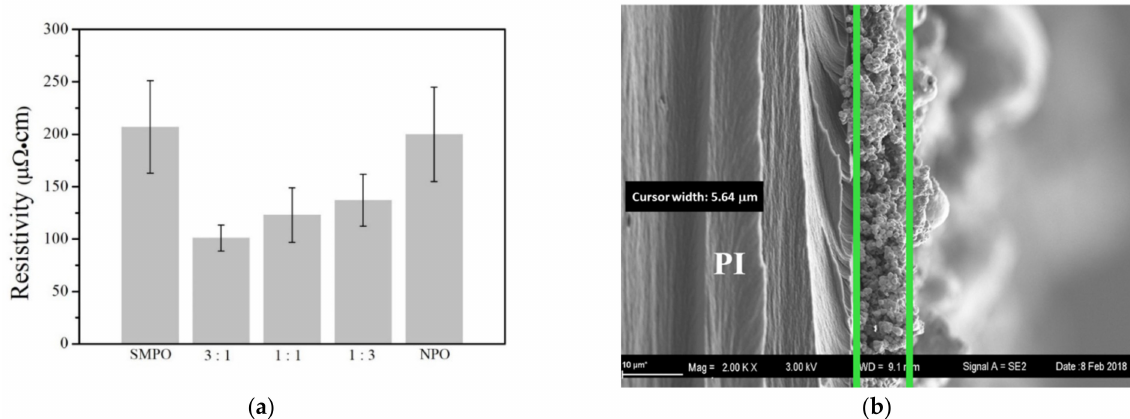
Figure 3. ( a ) Electrical resistivity of sintered structure with various SMPO/NPO weight ratios, and ( b ) cross-sectional image of sintered SMPO samples. Three flash pulses were used to NPO, and four were used to the other samples.